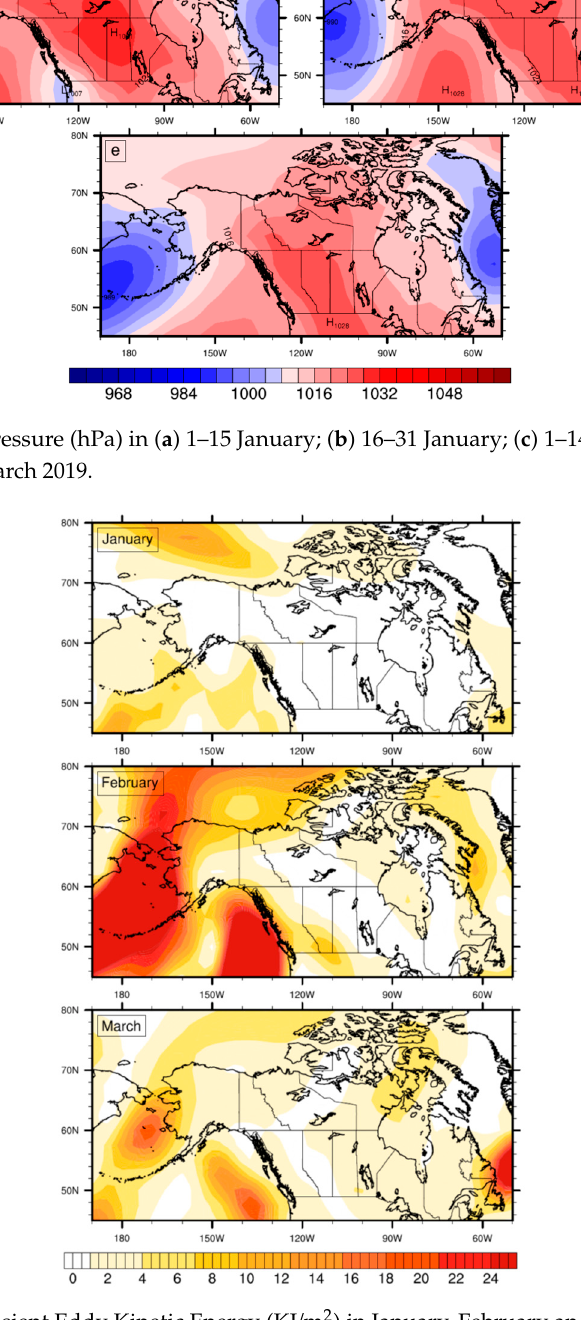
Figure 6. Transient Eddy Kinetic Energy (KJ/m 2 ) in January, February and March 2019.